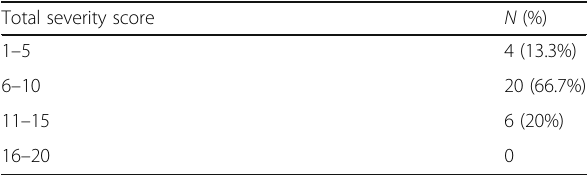
Table 3 The total severity score